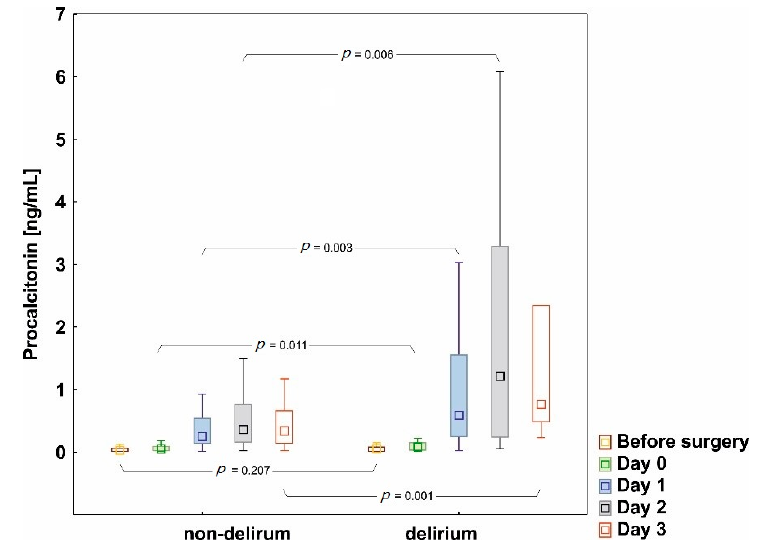
Figure 3. Procalcitonin concentrations in the group with and without postoperative delirium; p -values indicate statistically significant differences between groups; boxplot showing minimum and maximum (whiskers), median (middle point), and IQR values (box).